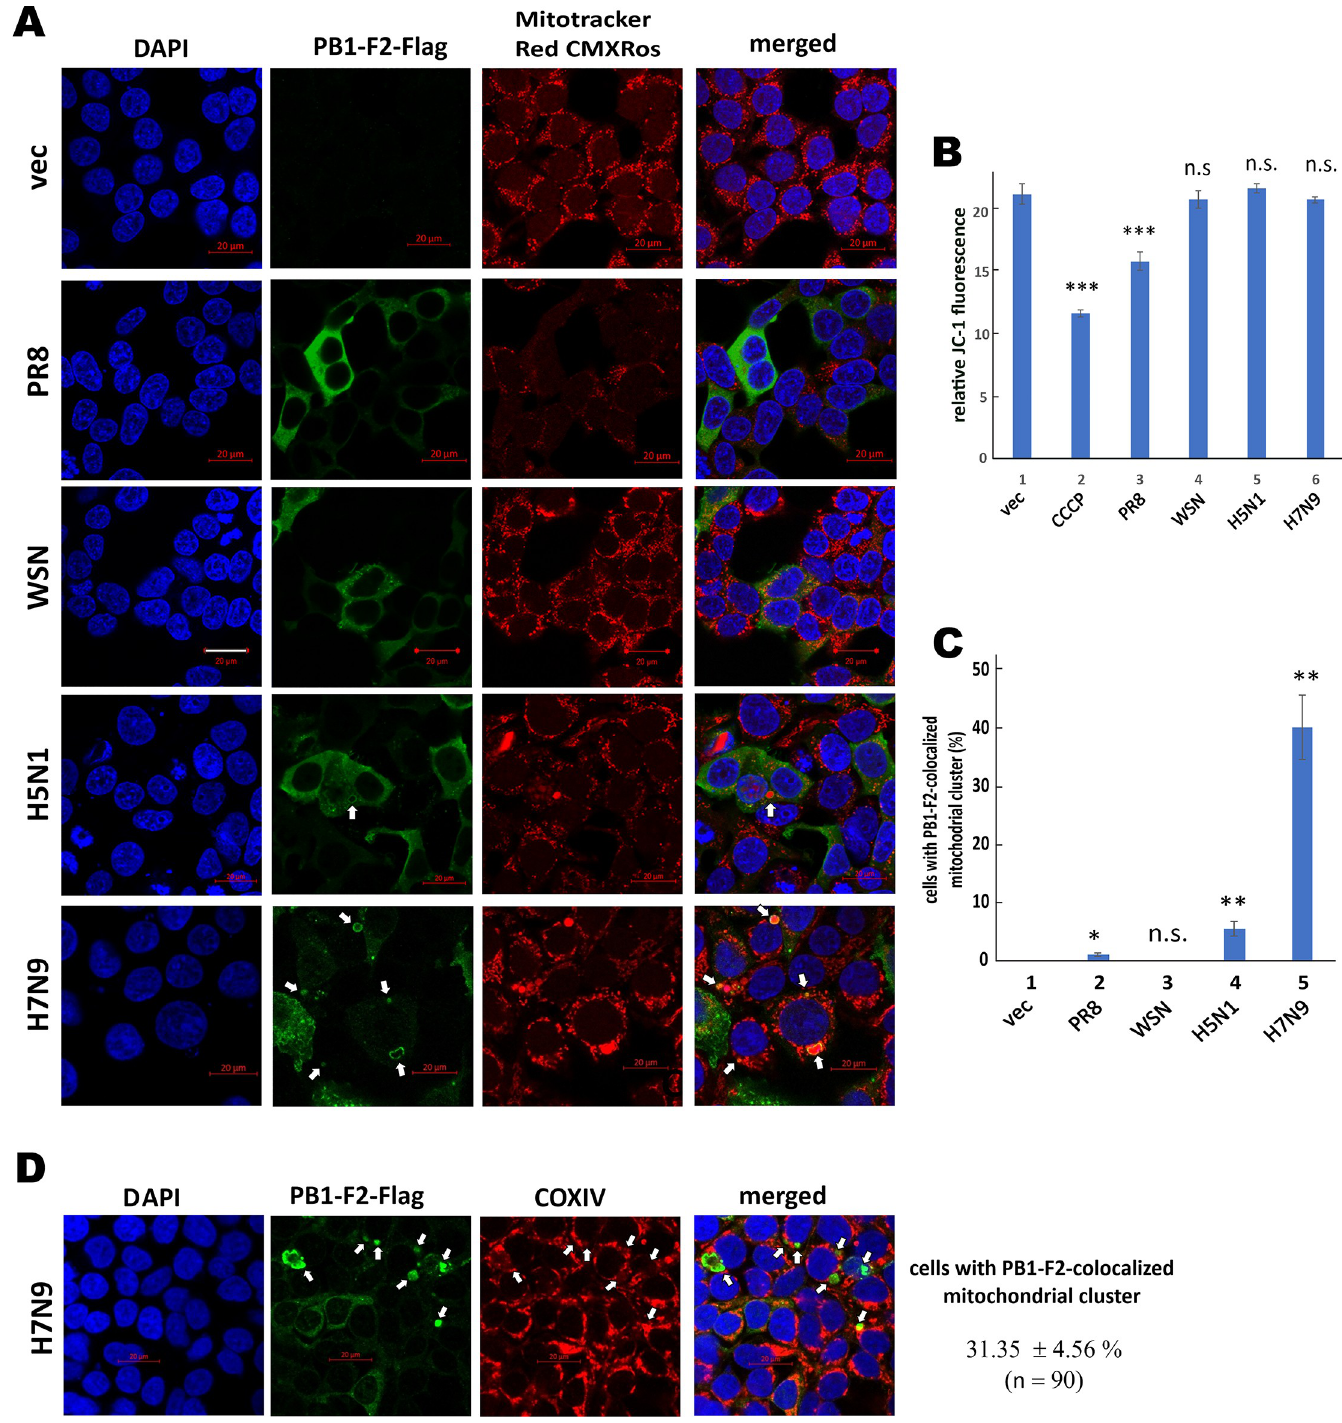
Fig 2. Influence of H7N9 PB1-F2 expression on mitochondrial morphology and function. ( A ) Mitotracker Red CMXRos staining. HEK293T cells over coverslips in 6-well plates were transfected with 1 μ g of PB1-F2-Flag expression construct. After 48 hours, cells were stained with 500 nM Mitotracker Red CMXRos for 30 min and then fixed with 4% paraformaldehyde. PB1-F2 was probed with anti-Flag and nuclei were stained with DAPI. The stained cells were analyzed by confocal microscopy. Arrows indicated distinct mitochondrial clusters colocalized with PB1-F2. vec: vector control. Bars, 20 μ m. ( B ) JC-1 staining. HEK293T cells in 12-well plates were transfected with 0.5 μ g of PB1-F2-Flag expression construct. After 48 hours, cells were stained with JC-1 dye. For CCCP control, cells were co-treated with 50 μ M CCCP and JC-1 dye. JC-1 dye-stained cells were analyzed through fluorescence microplate reader for red and green signals, which respectively indicated healthy and